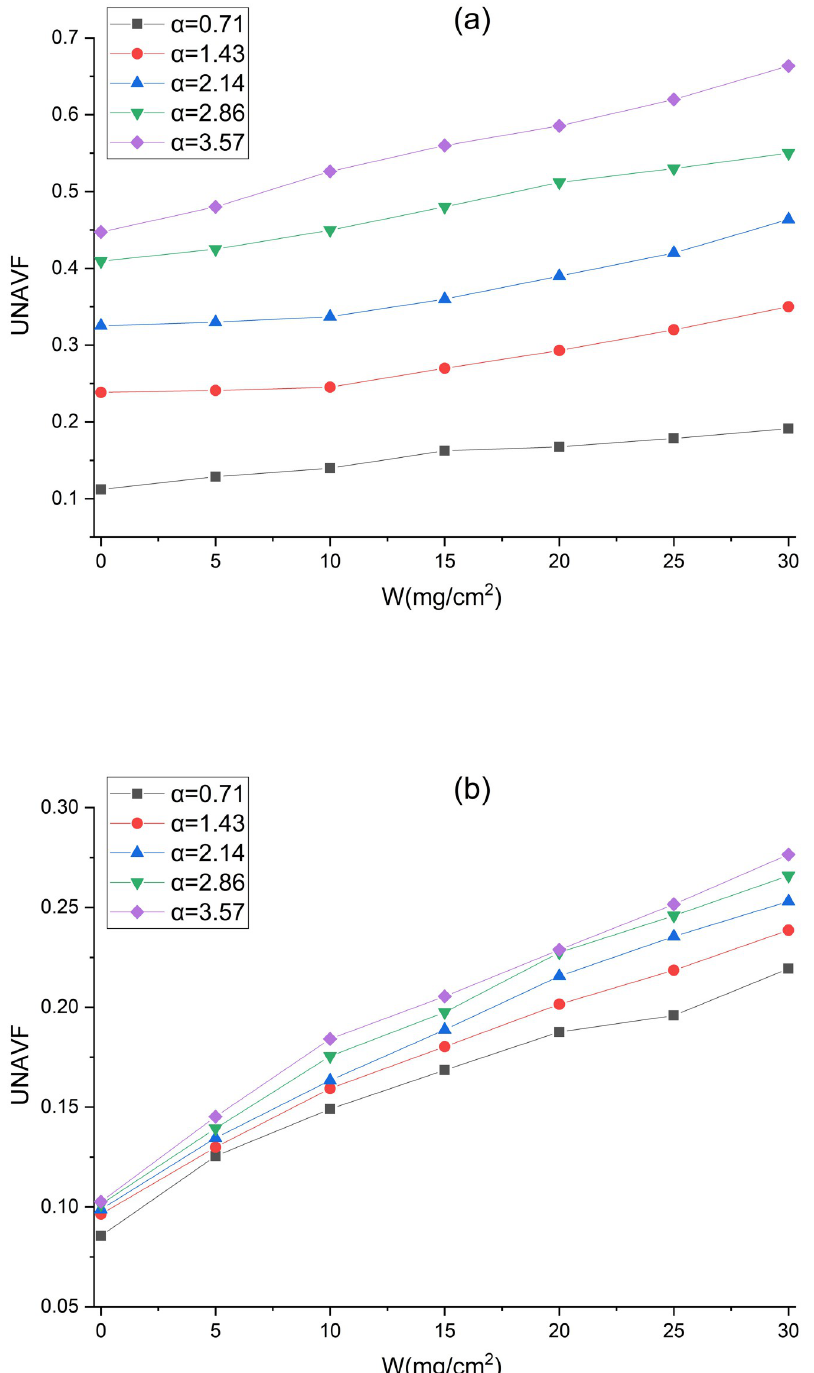
Fig 19. Changes in the NAVF with W (a) V-shaped; (b) U-shaped.